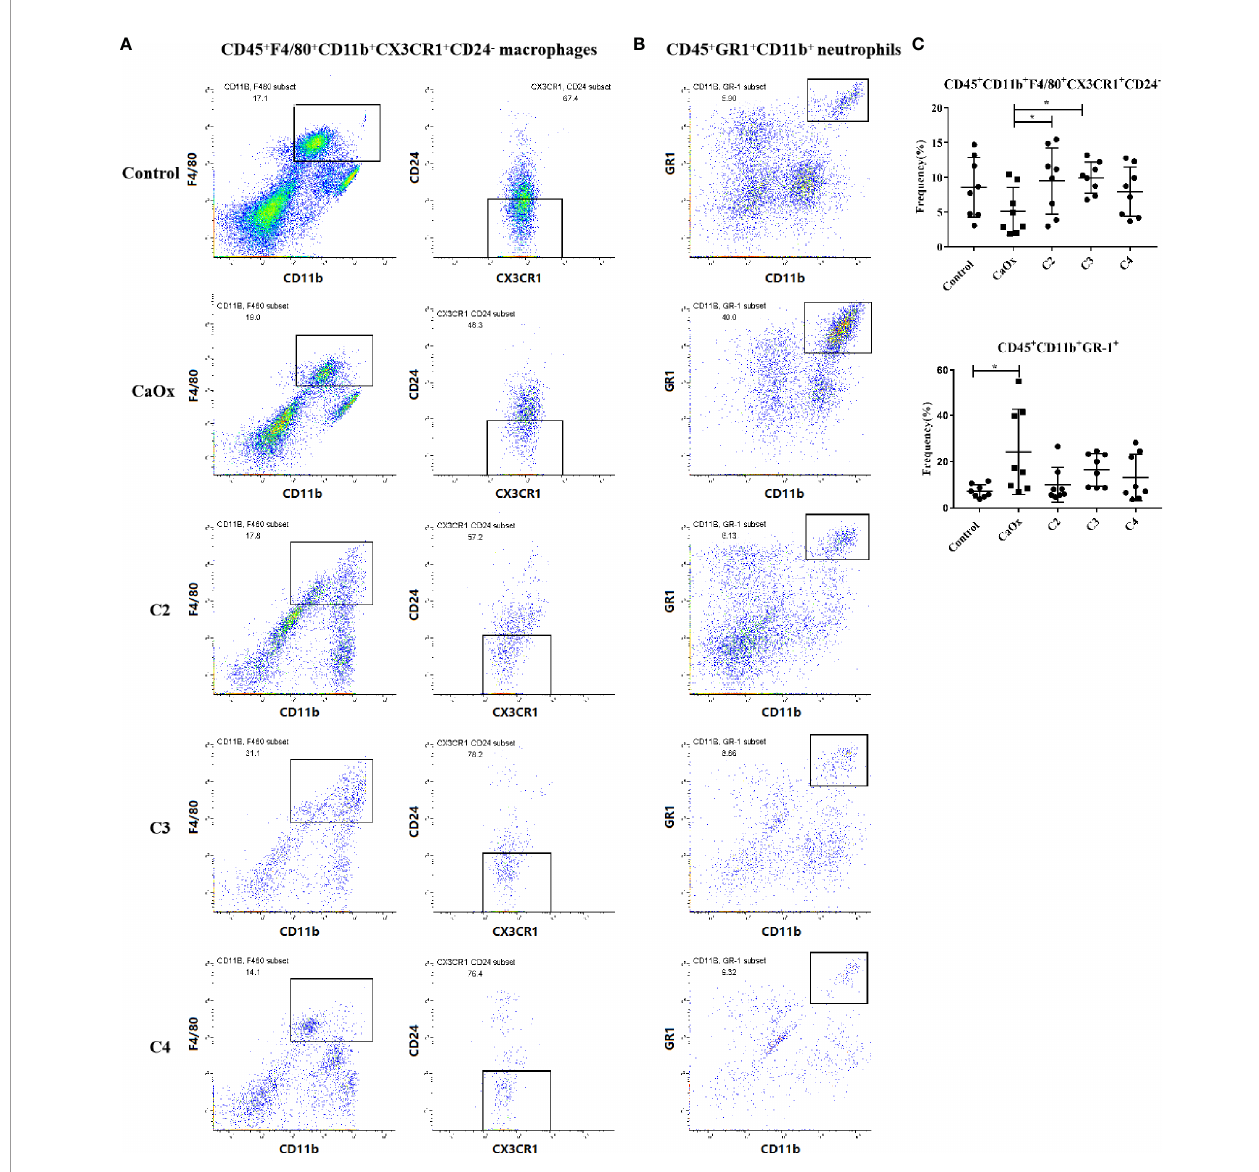
FIGURE 6 | Representative fl ow cytometric analysis of CD45 + F4/80 + CD11b + CX3CR1 + CD24 - macrophages and CD45 + GR1 + CD11b + neutrophil in CaOx crystal mice with or without administration of SCFAs. Gates were set on CD45 + cells, (A) macrophages then were gated on F4/80 + CD11b + cells followed by CX3CR1 + CD24 - , and (B) neutrophil were gated as GR1 + CD11b + in CD45 + cells. c Frequencies of CD45 + F4/80 + CD11b + CX3CR1 + CD24 - macrophages and CD45 + GR1 + CD11b + neutrophil in kidney with or without administration of SCFAs. (C) Frequencies of CD45 + F4/80 + CD11b + CX3CR1 + CD24 - macrophages and CD45 + GR1 + CD11b + neutrophil in kidney. Data were shown as mean ± standard deviation. Data were analyzed by one-way ANOVA followed by Tukey ’ s multiple comparisons test among multiple groups. Statistically signi fifi cant was shown as *p <